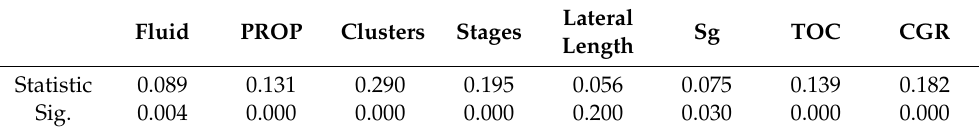
Table 4. The results of Kolmogorov-Smirnov Test.